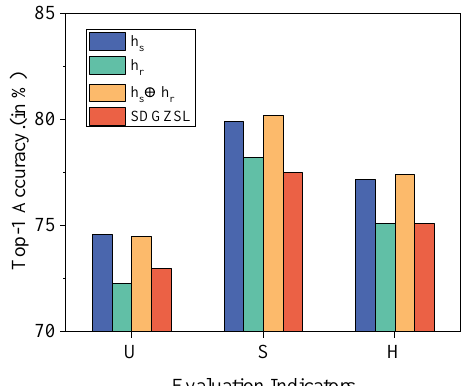
Figure 4. U , S , and H accuracy (%) comparison between SDGZSL, h s , h r , and h s ⊕ h r